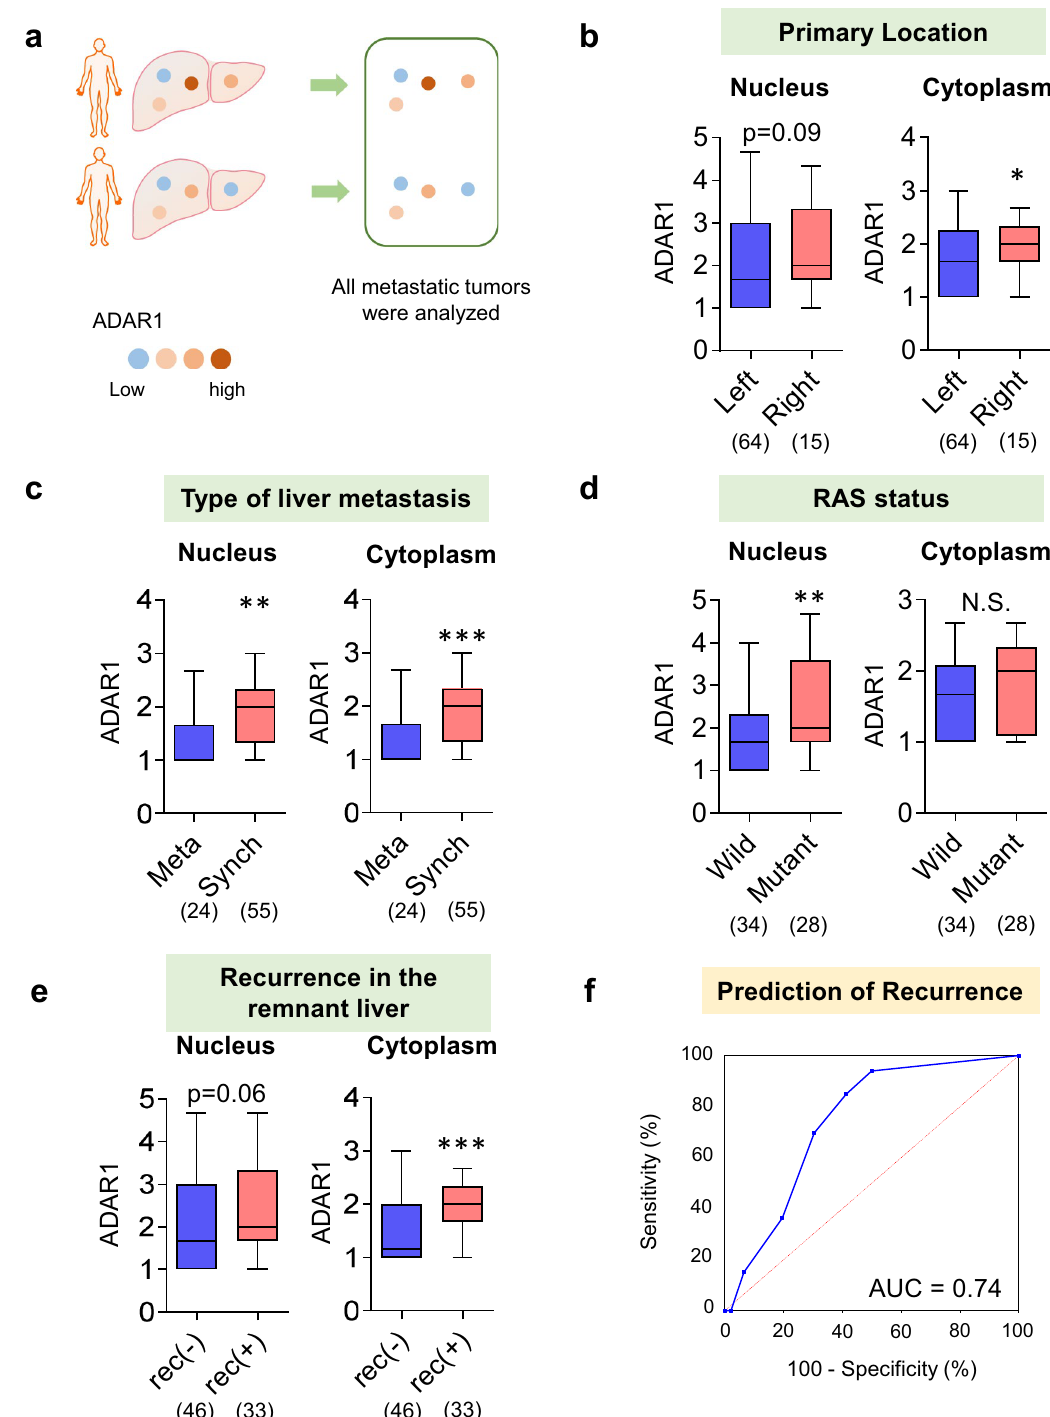
Figure 2. ADAR1 expression in each metastatic site. ( a ) In total, 83 liver metastases were characterized as independent tumor tissues. ( b–e ) The ADAR1 expression was upregulated in patients with liver metastases from right-sided colorectal cancer, concurrent liver metastases, RAS mutant-type cancer, and remnant liver recurrence. ( f ) A high ADAR1 expression was a predictive factor of remnant liver recurrence (area under the curve = 0.72). *p < 0.05, **p < 0.01, ***p <